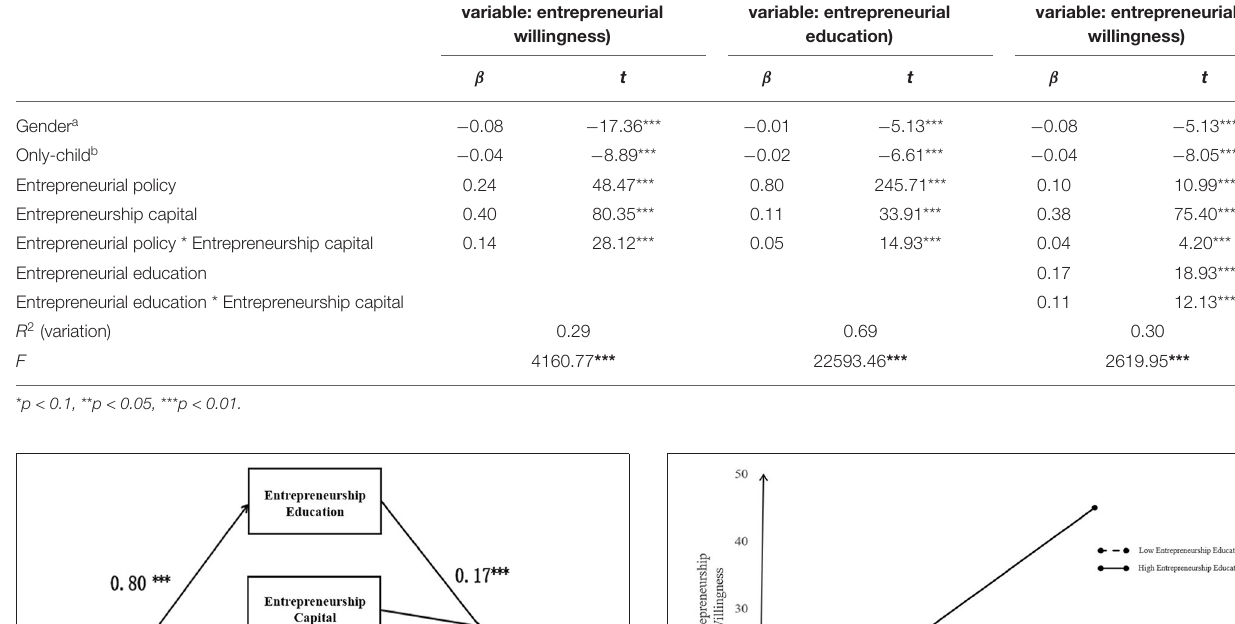
Equation 1 (Dependent variable: entrepreneurial